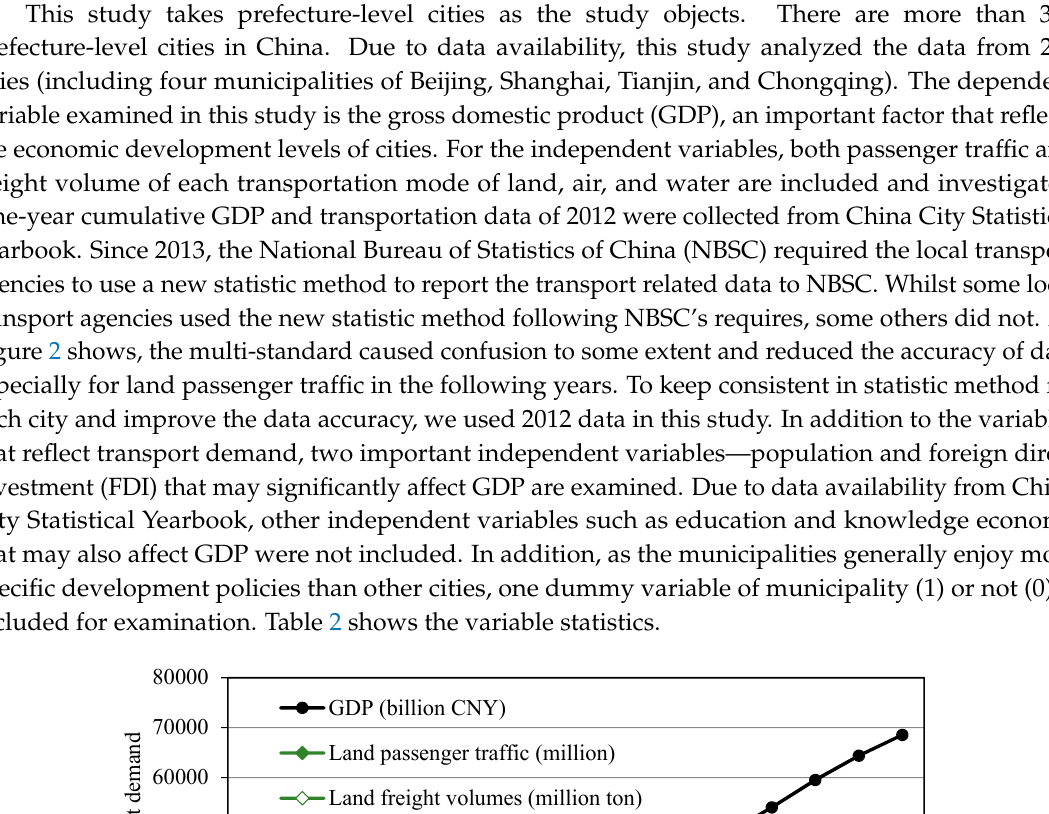
Table 1. Moran’s I test of the variables in China.